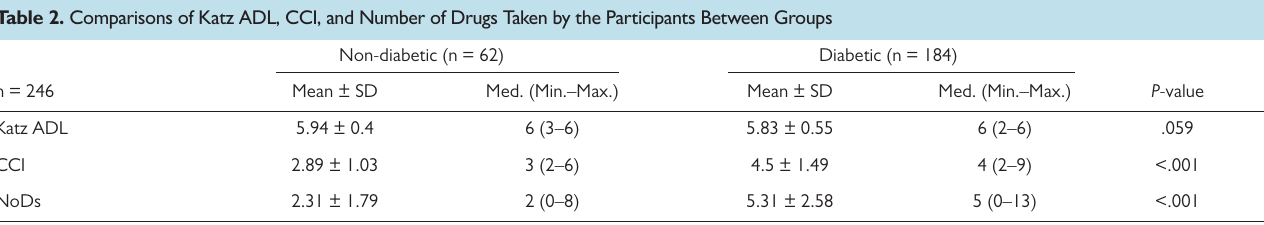
Table 2. Comparisons of Katz ADL, CCI, and Number of Drugs Taken by the Participants Between